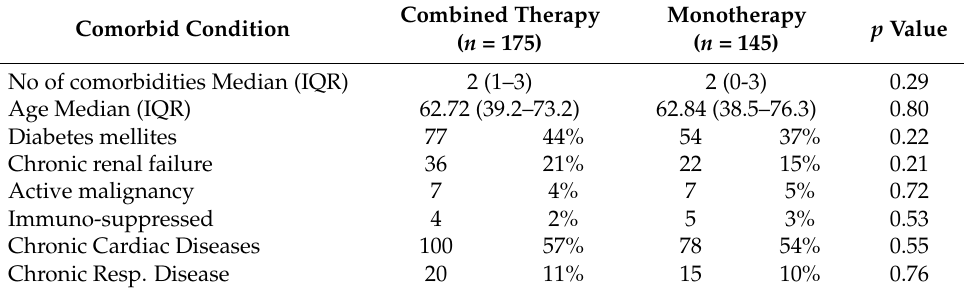
Table 4. Age and comorbidities in comparison